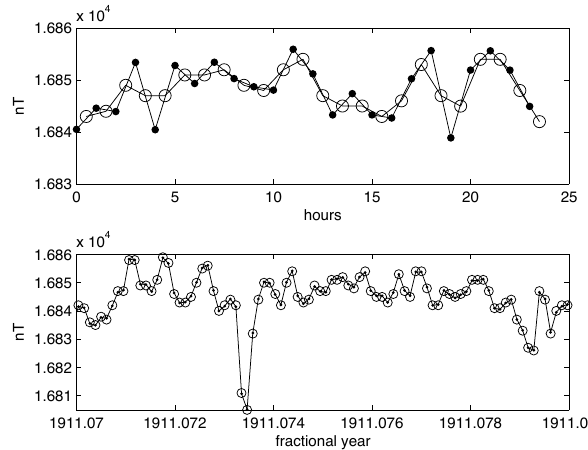
Fig. 2. Top: The ESK H component according to the observatory yearbook (line with black dots) and according to the WDC data base (line with circles) in 29 January 1911. The WDC data points are shifted by half an hour forward to demonstrate the fact that they are two-hour averages of the neighboring yearbook values. Bottom: The hourly ESK H values according to the WDC data (big open circles), together with the two-hour running means of the yearbook data (line with small dots) for a few days in January, 1911. Coin- ciding dots and circles give further evidence that the WDC data are running averages of the yearbook data.